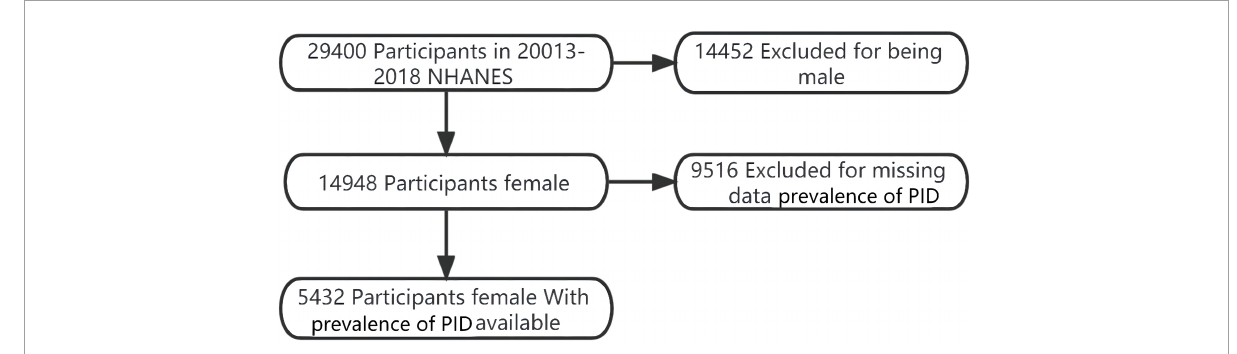
FIGURE1 Flowchart of study participant selection: from 2013 to 2018 NHANES. A total of 26,026 individuals remained after satisfying inclusion and exclusion criteria.